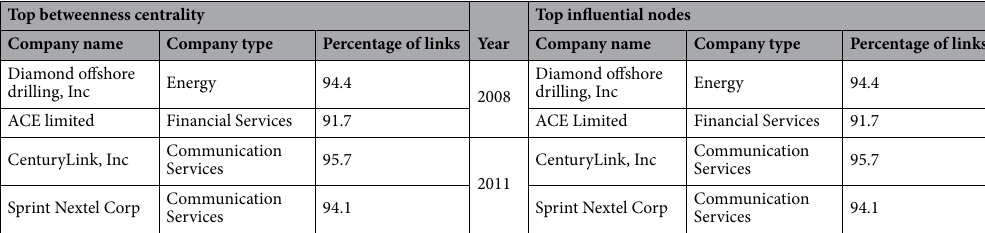
Table 1. Top 2 central and most influential stocks of the year 2008 and 2011 of s&p500. The energy and financial services companies were the most leading in the market during global financial crisis while communication services companies were in ESD